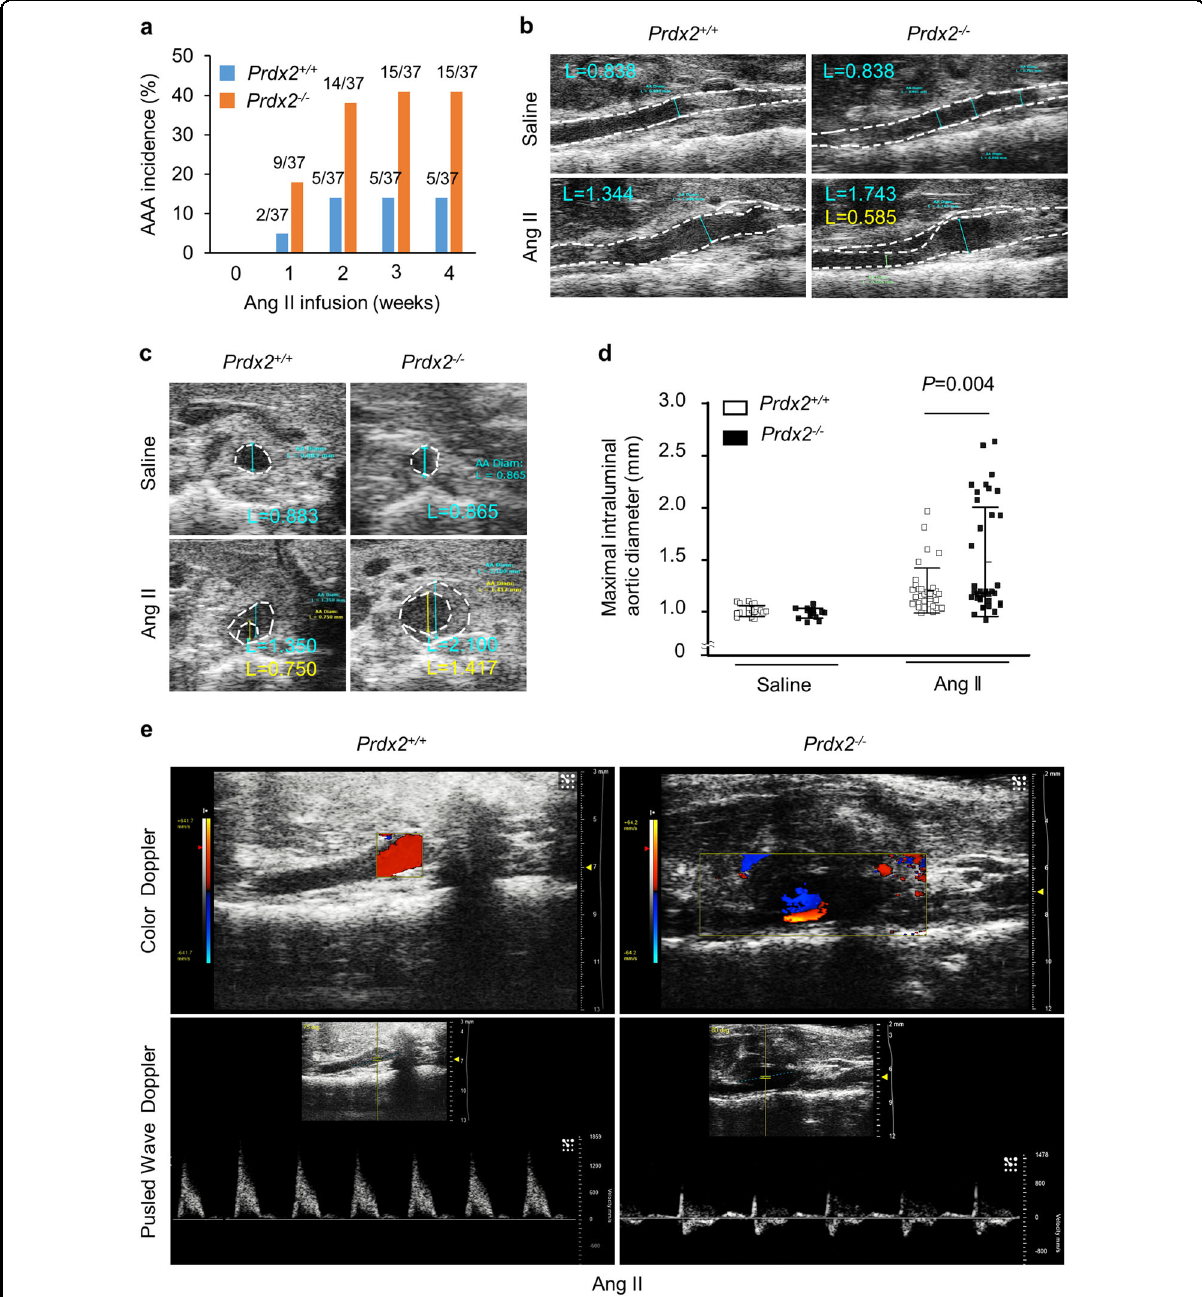
Fig. 2 Loss of PRDX2 increases AAA incidence and aortic dilatation by Ang II. a The incidence of AAA (%) was evaluated using ultrasound imaging for 4 weeks in Prdx2 + / + and Prdx2 − / − mice infused with Ang II ( n = 37). b Representative ultrasound imaging of the long axis and c the short axis of the suprarenal regions of Prdx2 + / + and Prdx2 − / − mice infused with saline or Ang II. d Quanti fi cation of the maximal intraluminal aortic diameter of the suprarenal regions from Prdx2 + / + and Prdx2 − / − mice infused with saline ( n = 15 – 20) or Ang II ( n = 37) by ultrasound imaging. Data are presented as the mean ± SEM (two ‐ tailed Student ’ s t test). e Representative ultrasound images of the long axis obtained from color Doppler (top) and pulse wave (bottom) mode in the suprarenal regions of Prdx2 + / + and Prdx2 − / − mice infused with Ang